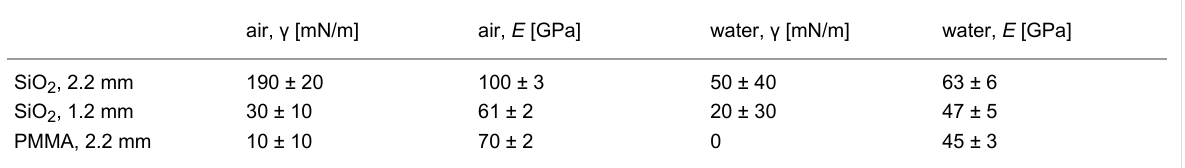
Table 1: Fit Parameters for the data in Figure 5. air, γ [mN/m] air, E [GPa] water, γ [mN/m] water, E [GPa] SiO 2 , 2.2 mm 190 ± 20 100 ± 3 50 ± 40 63 ± 6 SiO 2 , 1.2 mm 30 ± 10 61 ± 2 20 ± 30 47 ± 5 PMMA, 2.2 mm 10 ± 10